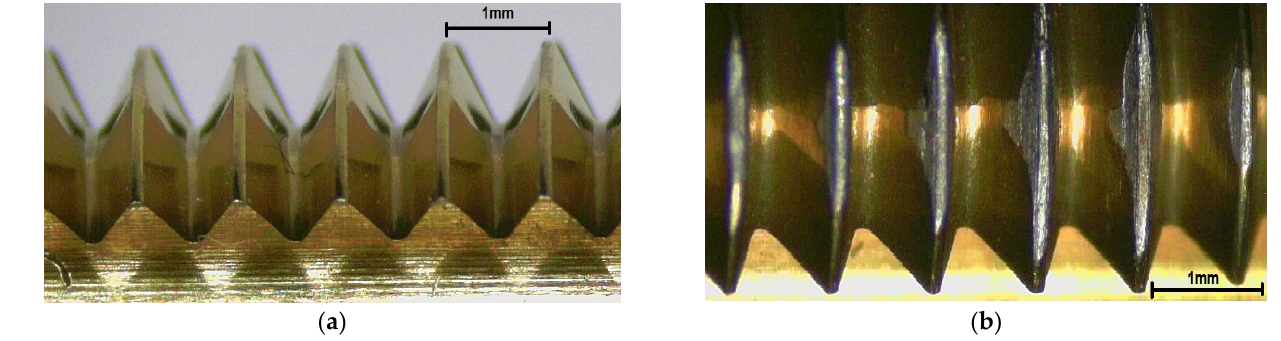
Figure 14. Wear of the taps: ( a ) a new tool, ( b ) at the end of tests.